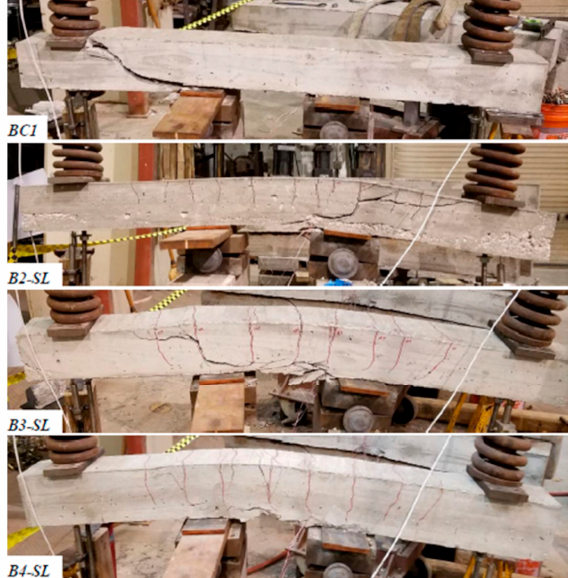
Figure 10. Load vs. deflection response of beam series II.